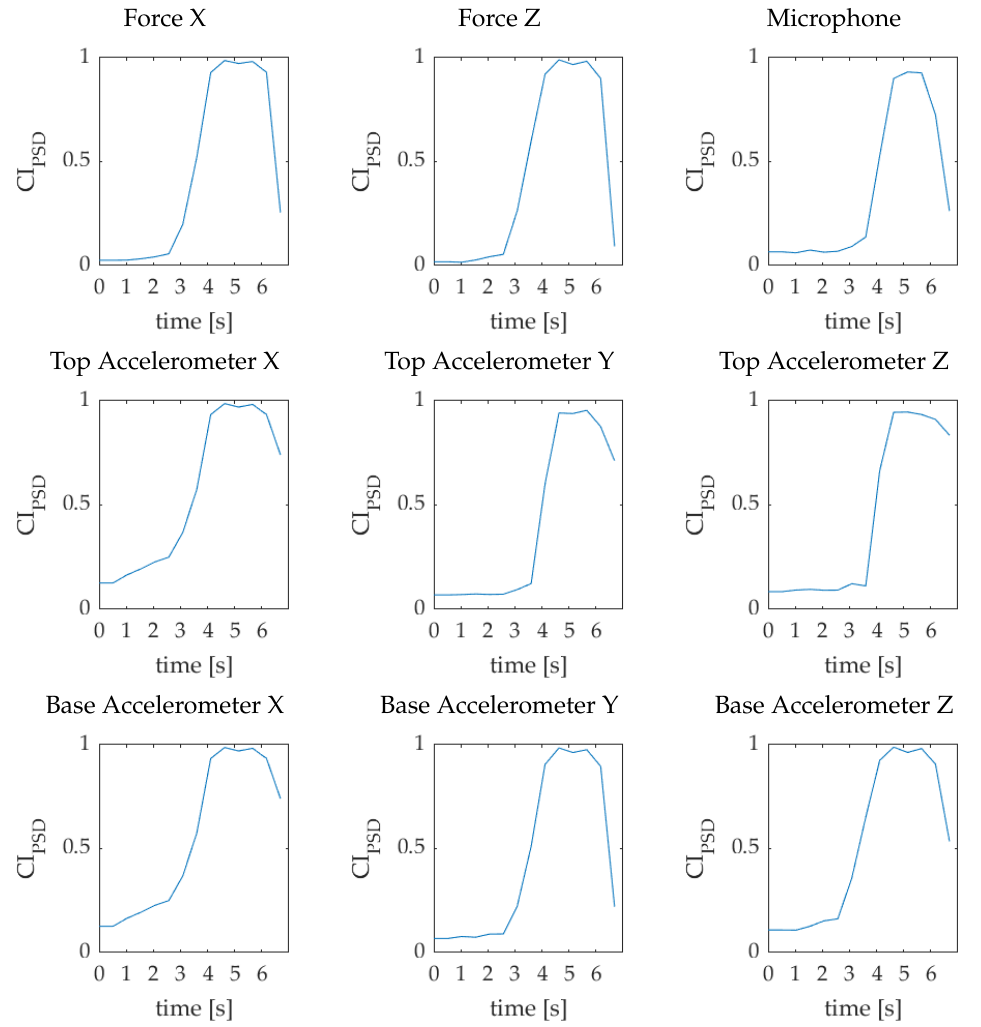
Figure 15. PSD chatter indices for Experiment 2.